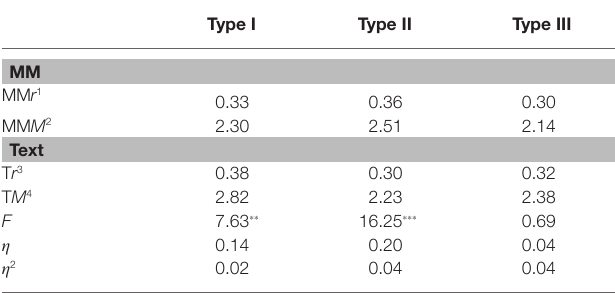
TABLE 4 | Relative and mean values of learning outcomes from multimedia (MM) compared to text